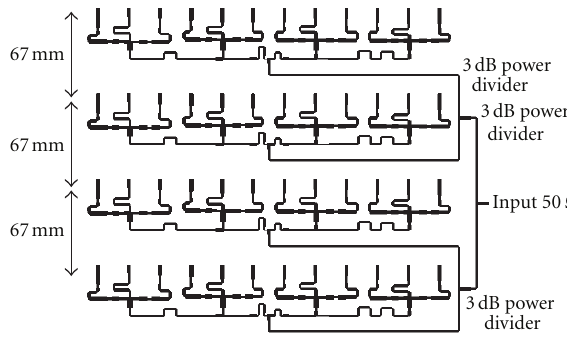
Figure 10: Comparison of the S 11 of the entire structure simulation (12 monopoles connected with the feed network) with the realized structure.